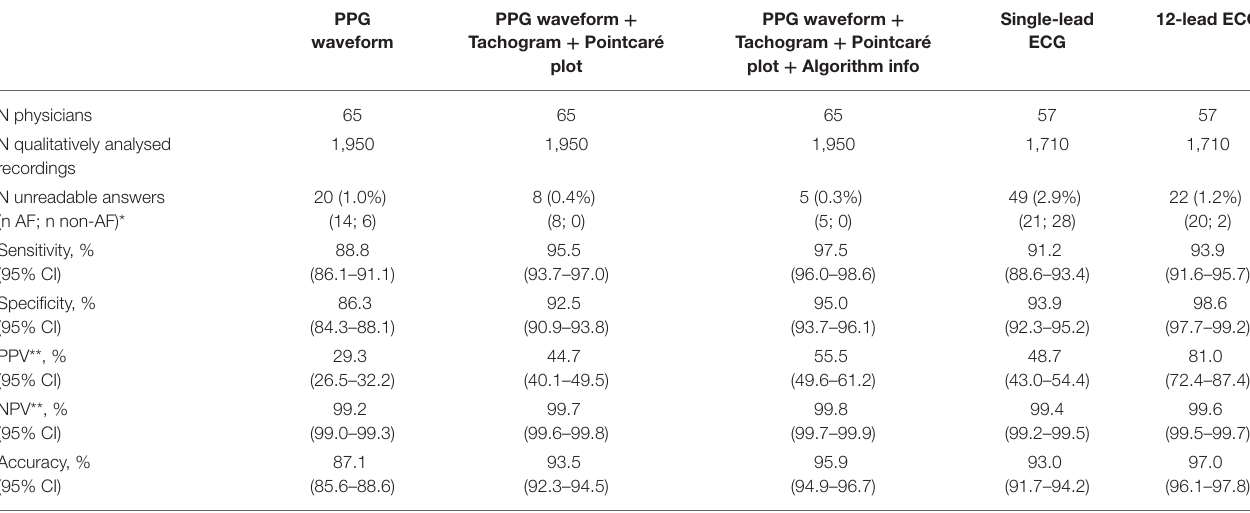
TABLE 2 | Accuracy metrics of the qualitative PPG, single-lead ECG, and 12-lead ECG analysis.